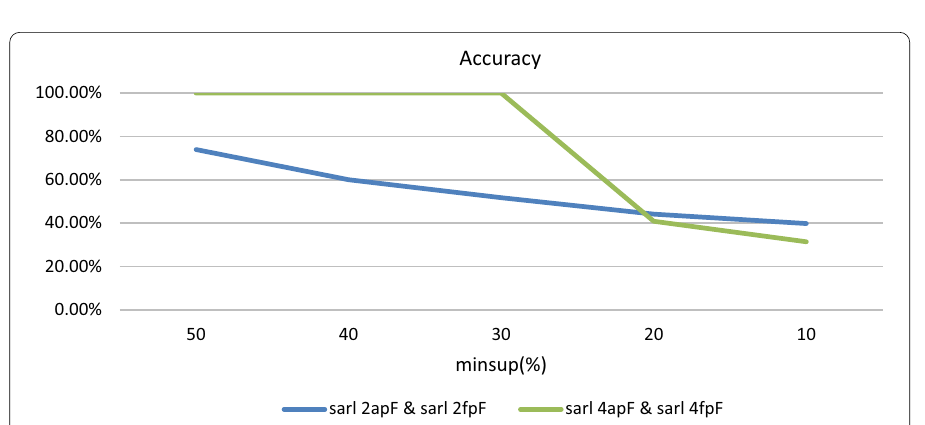
Fig. 7 Accuracy of different configurations of SARL heuristic on the Bible